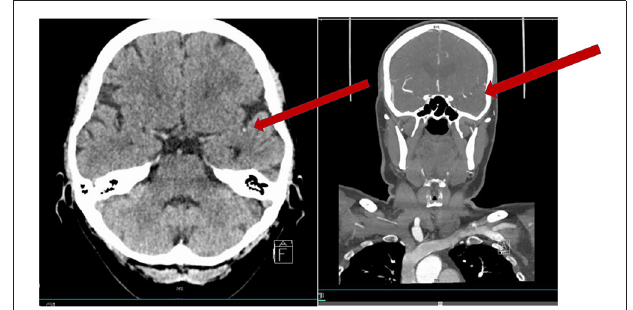
FIGURE 1 | Fifty-nine-year-old woman with an acute onset of aphasia (NIHSS 1 disabling). CT scan showing a hyperdense vessel sign in M2 (arrow). CTA showing the occlusion in M2 (short in length).